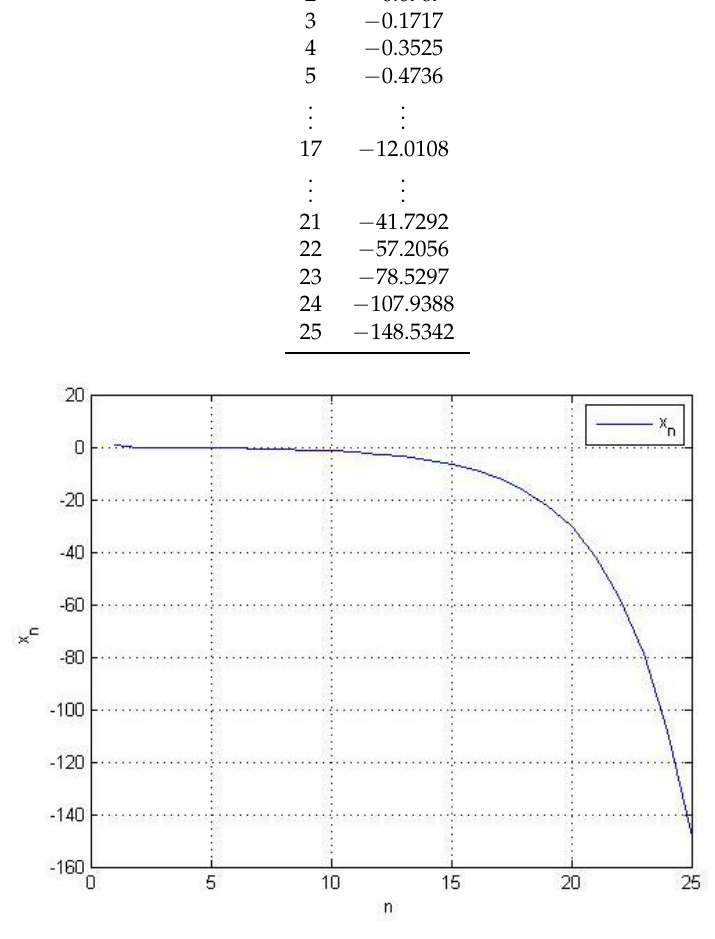
Figure 2. The sequence { x n } is divergence with initial values x 1 = 1, N = 100 and n =